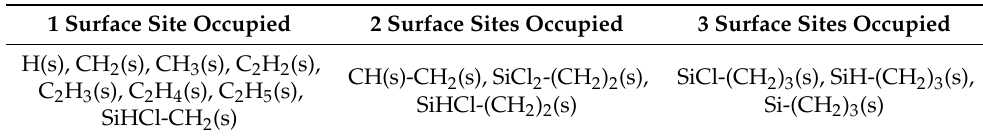
Table 2. Surface species occupy 1 surface site or 2/3 surface sites on Si